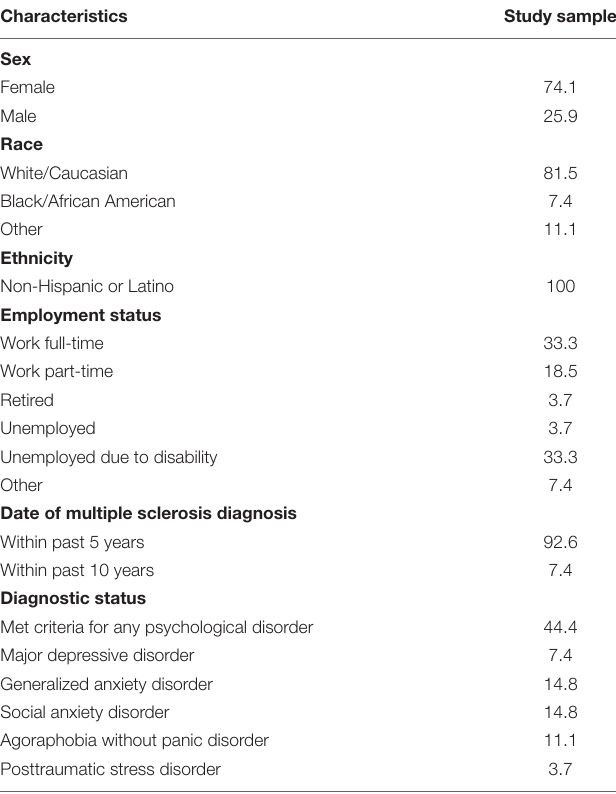
TABLE 1 | Characteristics of study participants as a percentage of the sample ( n =